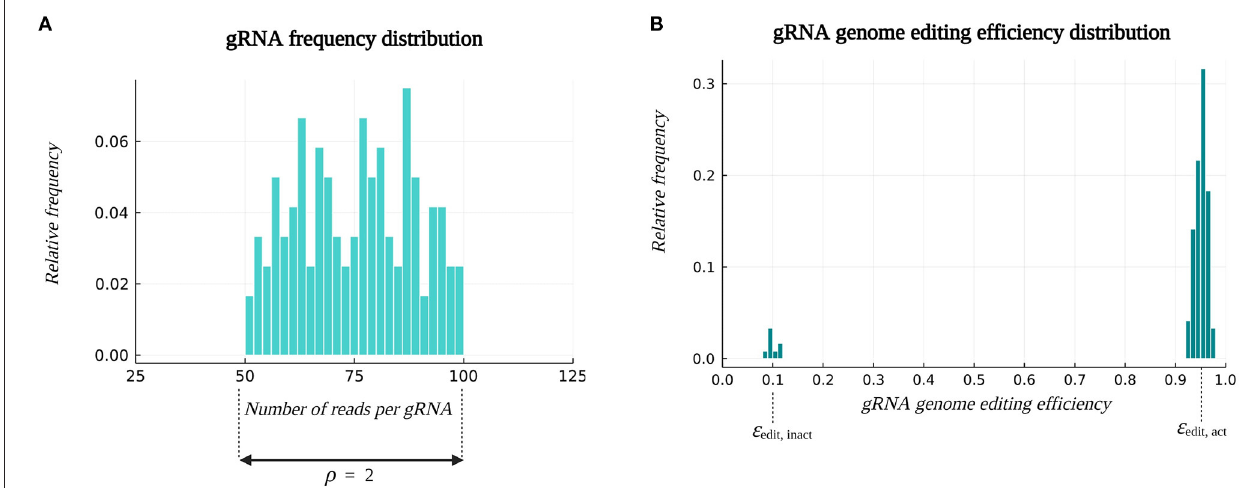
FIGURE 3 | Example of default distributions. (A) The gRNA frequency distribution in the construct library. Parameter ρ denotes the ratio of the frequency of the most abundant gRNA to the frequency of the least abundant gRNA, and is by default set at the value of 2. (B) The gRNA genome editing efficiency distribution. By default, 90 % of the gRNAs are active, having an average genome editing efficiency ǫ edit,act of 0.95, and 10 % of the gRNAs are inactive, characterized by an average genome editing efficiency